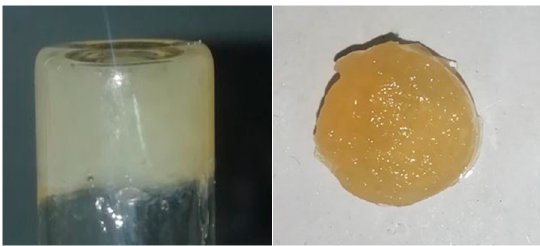
Figure 2. Physically crosslinked hydrogels formed in the equimolar mixtures (1:1) of chitosan hydrochloride and pectin.